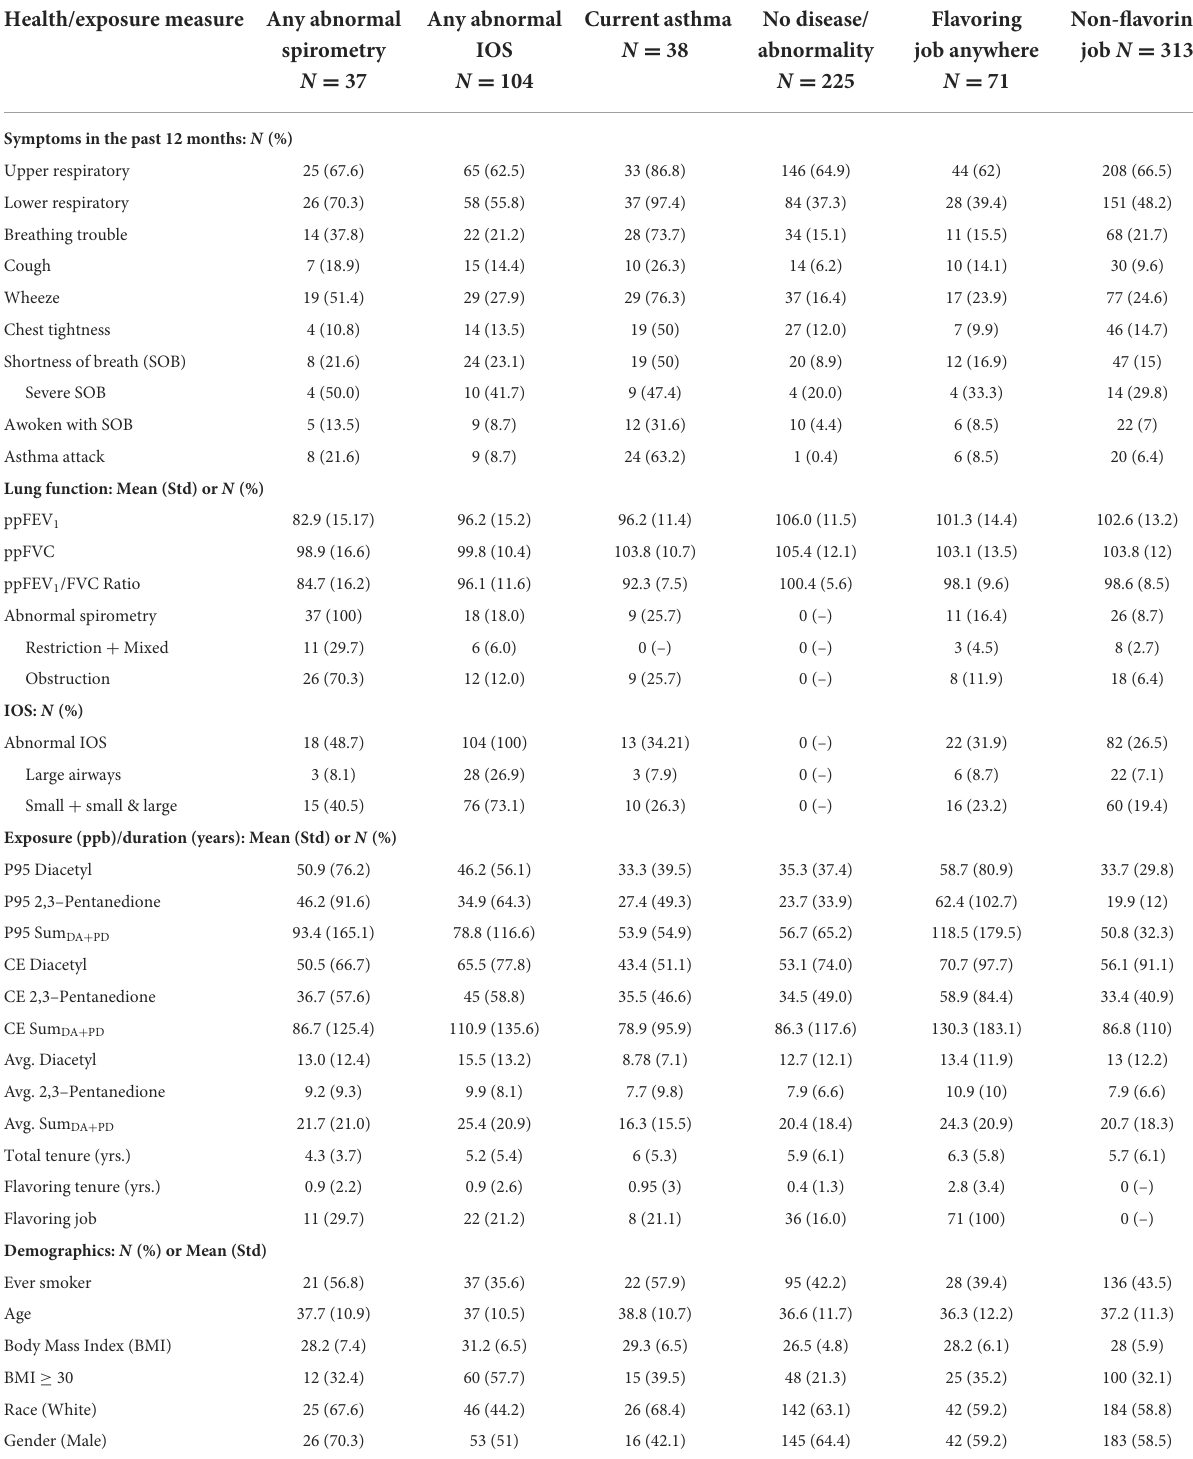
TABLE 1 Summary of respiratory health outcome and exposure characteristics by categories of health and flavoring